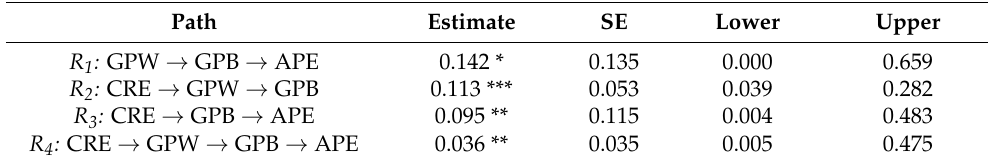
Table 9. Standardized bootstrap mediating effect